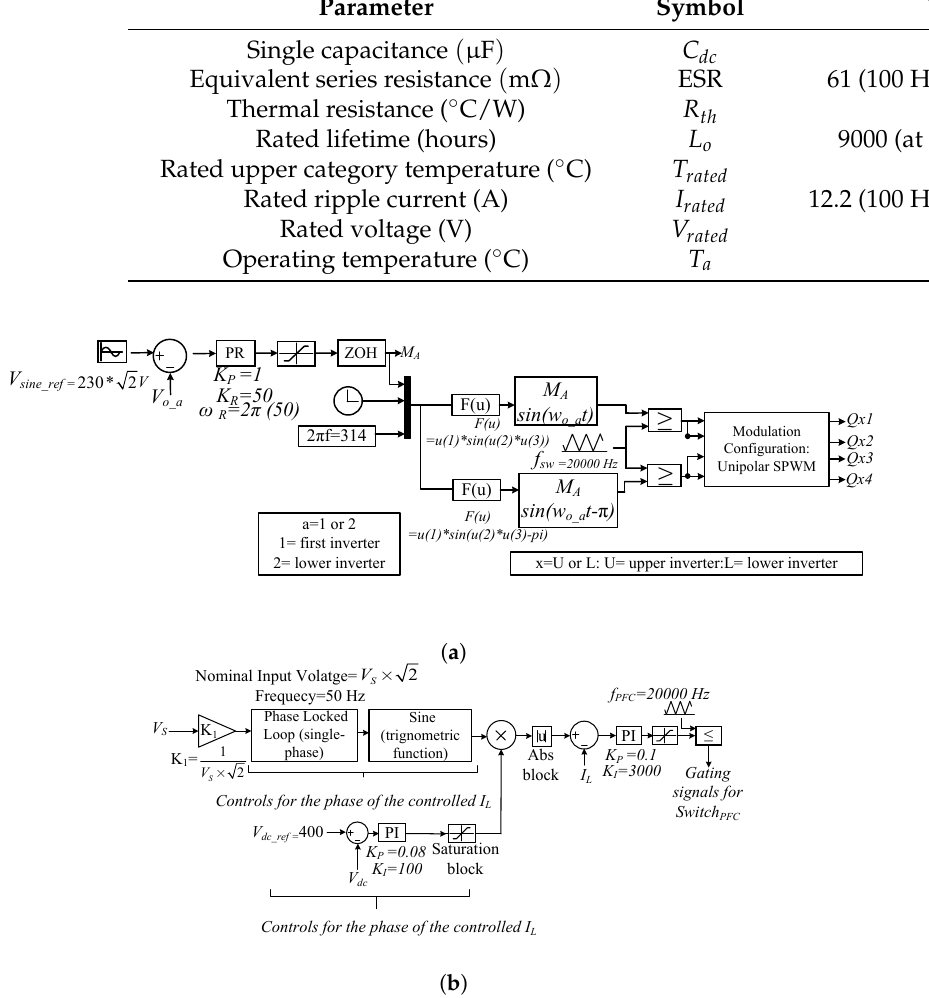
Figure 4. Control algorithm: ( a ) inverter, ( b ) boost PFC − where nominal input voltage of the phase lock loop is given √ as V S × 2. ( K P − Proportional parameter, K I − Integral parameter, K R − Resonant coefficient, ω R − Resonant frequency, √ K 1 = 1/( V S ×